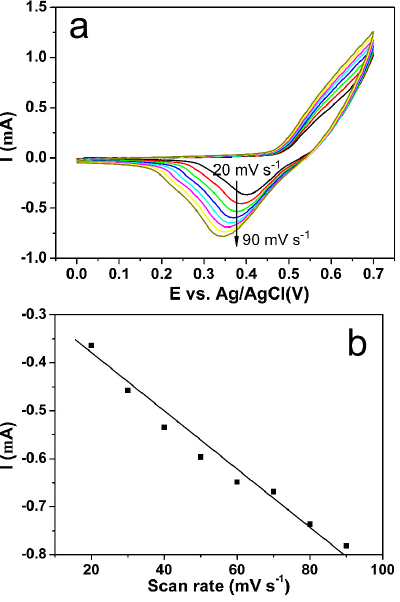
Figure 7. ( a ) Cyclic voltammograms of NiFe/GO/GCE at different scan rates from 20 to 90 mV/s in 0.1 M NaOH with 1.0 mM glucose. ( b ) Plot of cathode current vs the scan rate.